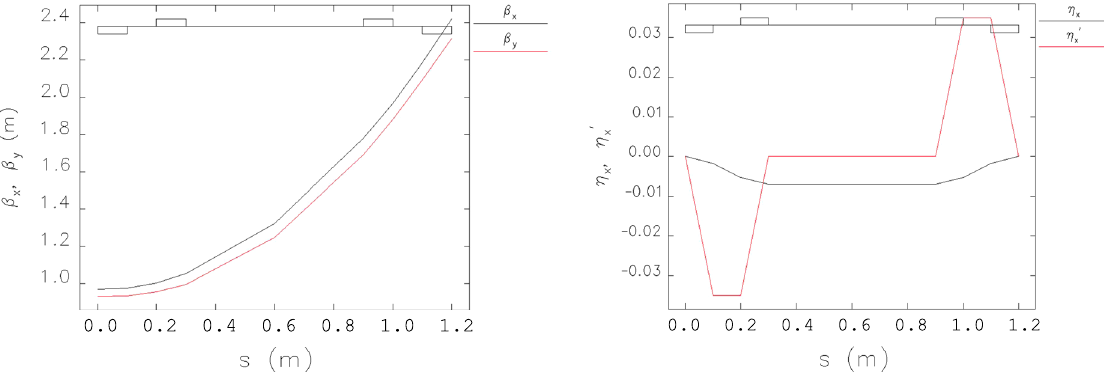
FIG. 6. Betatron functions (left), horizontal energy dispersion function and their s derivatives (right) calculated along NIEM at 100